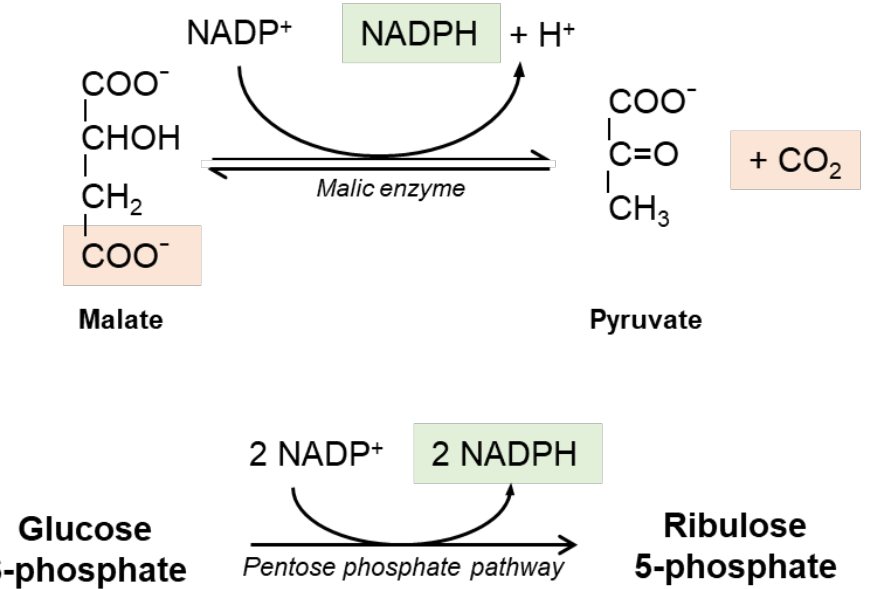
Figure 2. The pentose phosphate pathway and the malic enzyme reaction. The pentose phosphate pathway is considered the main source of reducing equivalents used for GSH regeneration; it is also the sole source of NADPH in red blood cells. The malic enzyme is another relevant source of NADPH in hepatic cells. in hepatic